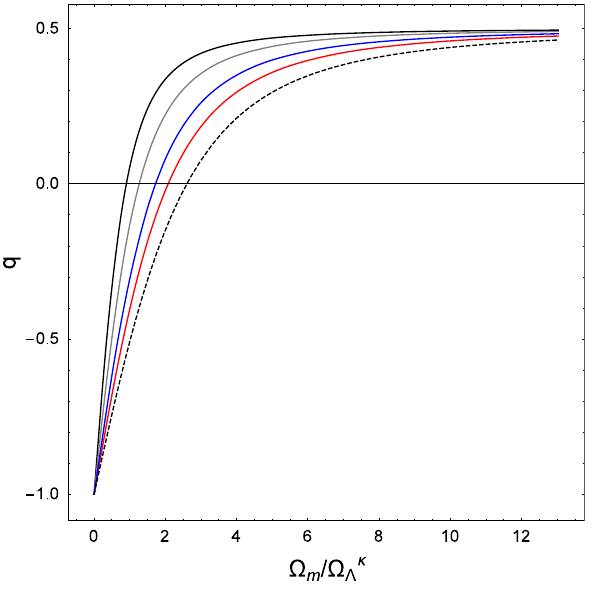
Fig. 3 The behavior of deceleration parameter against the ratio (cid:8) /(cid:8) κ = 0 . 315, H 2 = 0 . 3025, (cid:8) 0 m (cid:7) for C m (cid:8) /(cid:8) κ ≈ 0 . 95 at z ≈ 0 . 570 for gray curve and (cid:8) m tr (cid:7) z tr ≈ 0 . 997 for black dashed curve